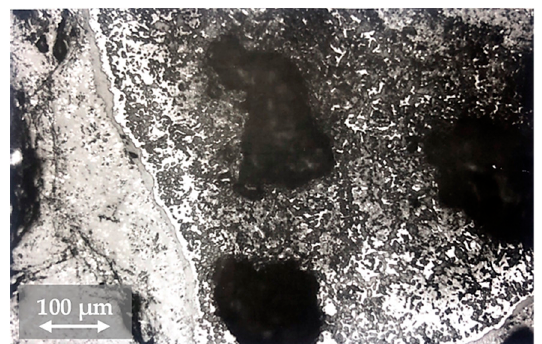
Figure 3. A lime part in the glassy silicate slag and the beginning of the formation of a dicalcium silicate margin after minute 5 of the refining process, melting process E, sample E5.